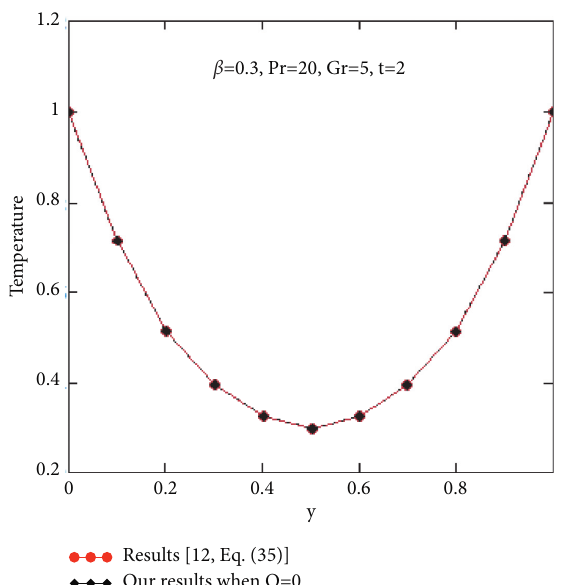
Figure 15: Temperature profiles of our models compared with the temperature profile of [12] f